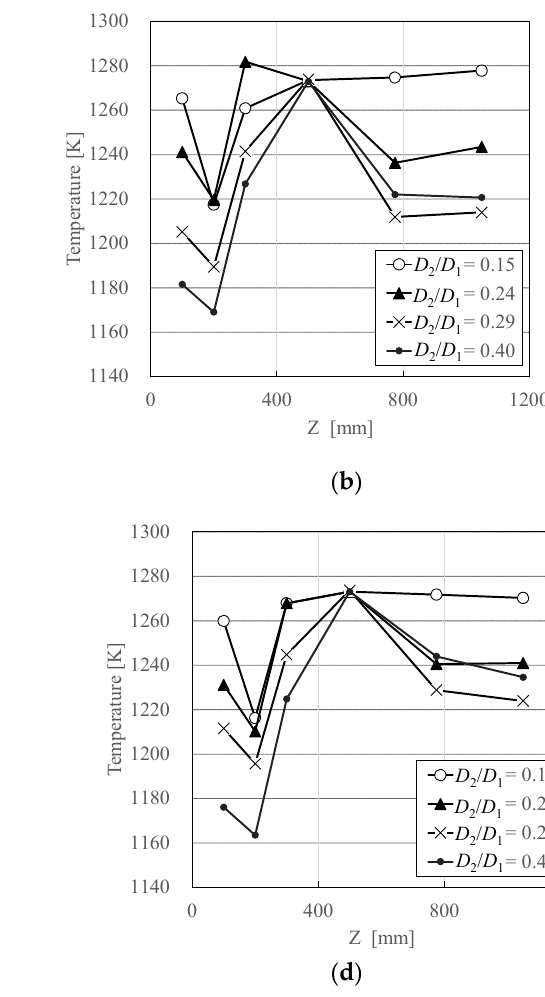
Figure 8. Comparison of temperature distribution for different D 2 / D 1 at ( a ) E NH3 = 10%; ( b ) E NH3 = 40%; ( c ) E NH3 = 60%; ( d ) E NH3 = 80%. Input = 11.63 kW, λ total = 1.2, L = 100 mm. 3.4. Relationship between Distance between Burner and Secondary Nozzles “L” and NOx Using the position of the primary air supply as the burner's inner tube diameter D 1 = 27.2 mm and the ratio L / D 1 , with the distance L being between the burner and the second- ary air nozzle, the NOx emissions rate for different L / D 1 in λ 1 = 0.6 and D 2 / D 1 = 0.24 is shown in Figure 9. In the L = 100 mm condition, L / D 1 = 3.68. When L / D 1 = 1.84, the NOx reduction effect became small, and the behavior became closer to single-stage combustion.